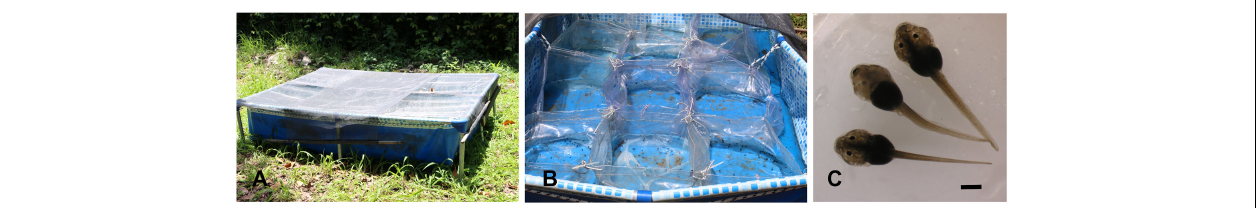
FIGURE 1 | (A) Containers with tadpoles were kept in two large receptacles, which were covered with a net to avoid bird predation. (B) Plastic containers (each one was identified with a label was assigned to a treatment) at the beginning of the experiments. (C) Tadpoles at Gosner Stage 25. The scale bar is equals 1